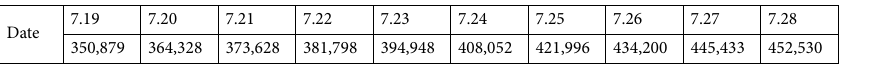
Table 3. Testing set data.